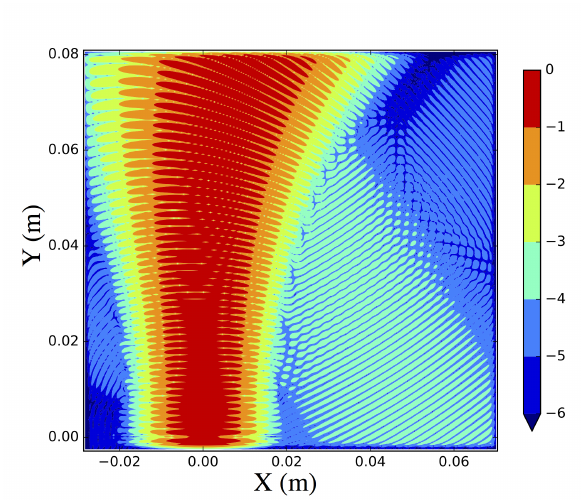
Figure 1. A snapshot of the decimal logarithm of the wave E - field magnitude for a CPML benchmark